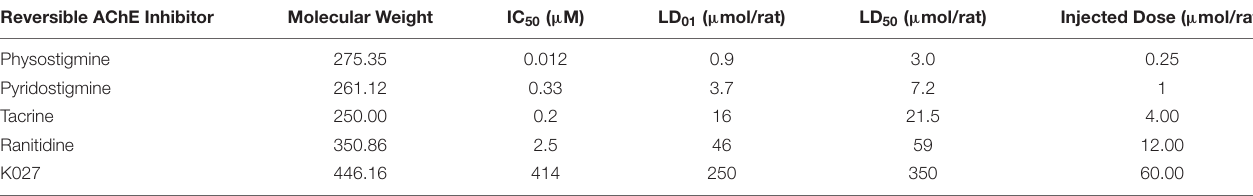
TABLE 5 | Chemical and biological parameters of the investigated inhibitors of AChE administered prophylactically before exposure to OPCs. Reversible AChE Inhibitor